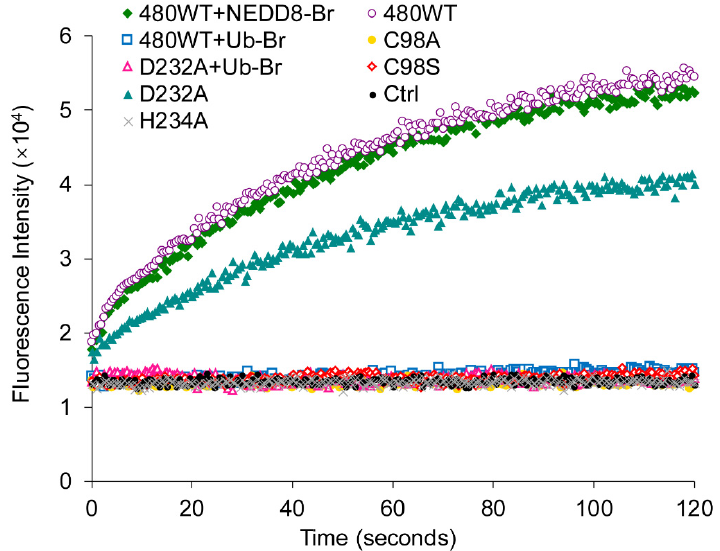
Figure 8. Identification of the catalytic activity of UL36 after incubation with probes. The markers in the scatter chart indicate fluorescence intensity of 7-amido-4-methylcoumarin (AMC) fluorophore released